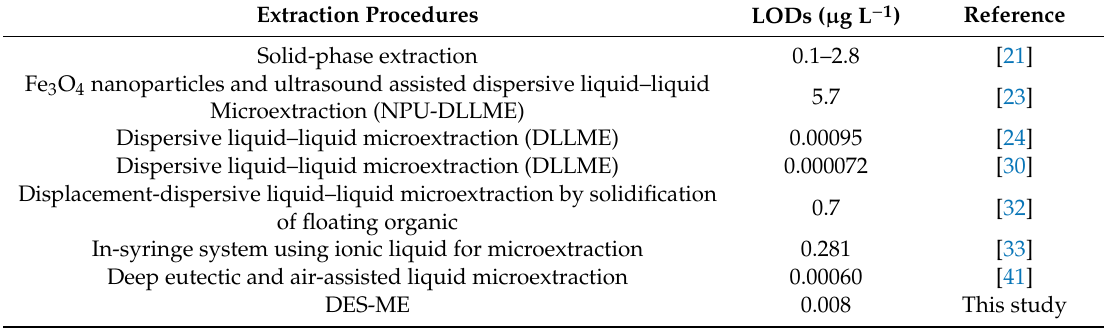
Table 5. A comparison of the developed DES-ME of Pb(II) with microextraction methods from the